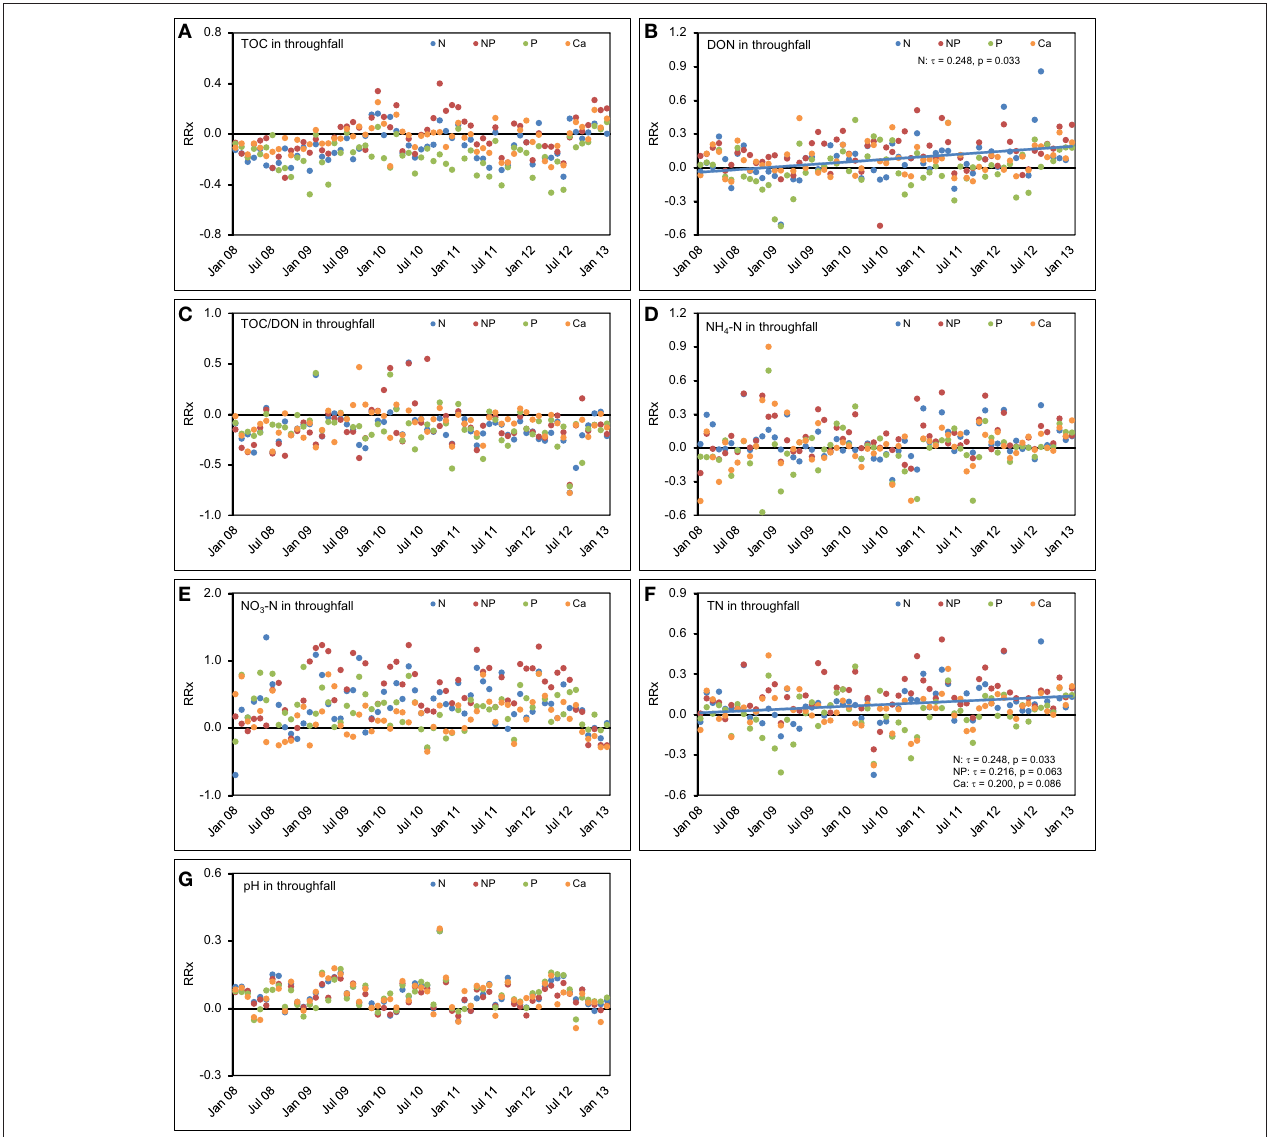
FIGURE 8 | Concentration time series in throughfall between January 2008 and December 2012. The figures show the course of the differences between the four treatments and the control plots expressed as natural log-response ratios (RRx) of (A) total organic carbon (TOC) concentrations, (B) dissolved organic nitrogen (DON) concentrations, (C) TOC/DON ratios, (D) concentrations of ammonium-N (NH 4 -N), (E) concentrations of nitrate-N (NO 3 -N), (F) concentrations of total nitrogen (TN), and (G) pH values in throughfall of the nutrient manipulation experiment (NUMEX). Solid lines illustrate significant trends in the dataset ( p < 0.05